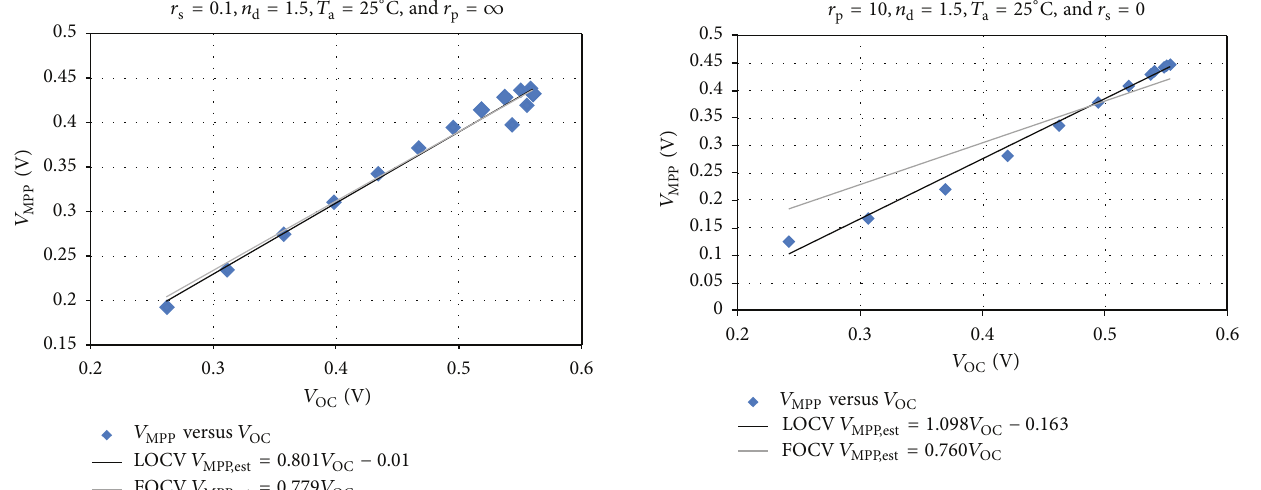
Figure 6: Computed 𝑉 = 25 ∘ C, 𝑛 𝑇 a lines corresponding to the FOCV and LOCV methods are also represented.